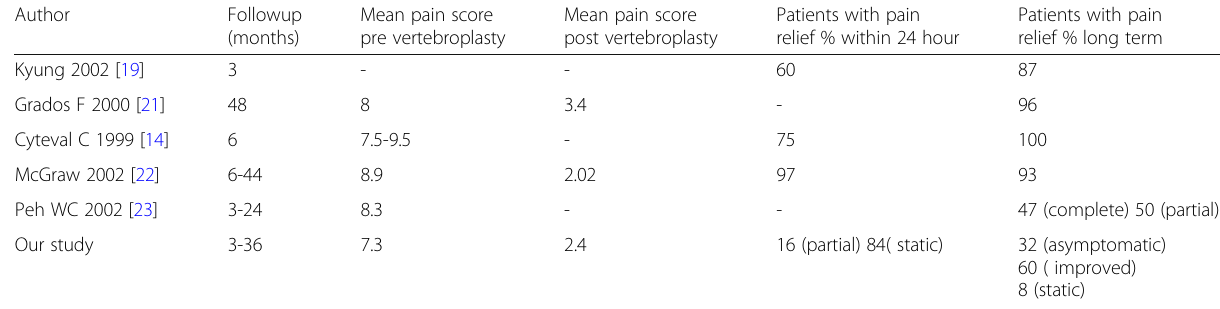
Table 9 depicting Effect of percutaneous vertebroplasty on pain relief in various studies compared to our study